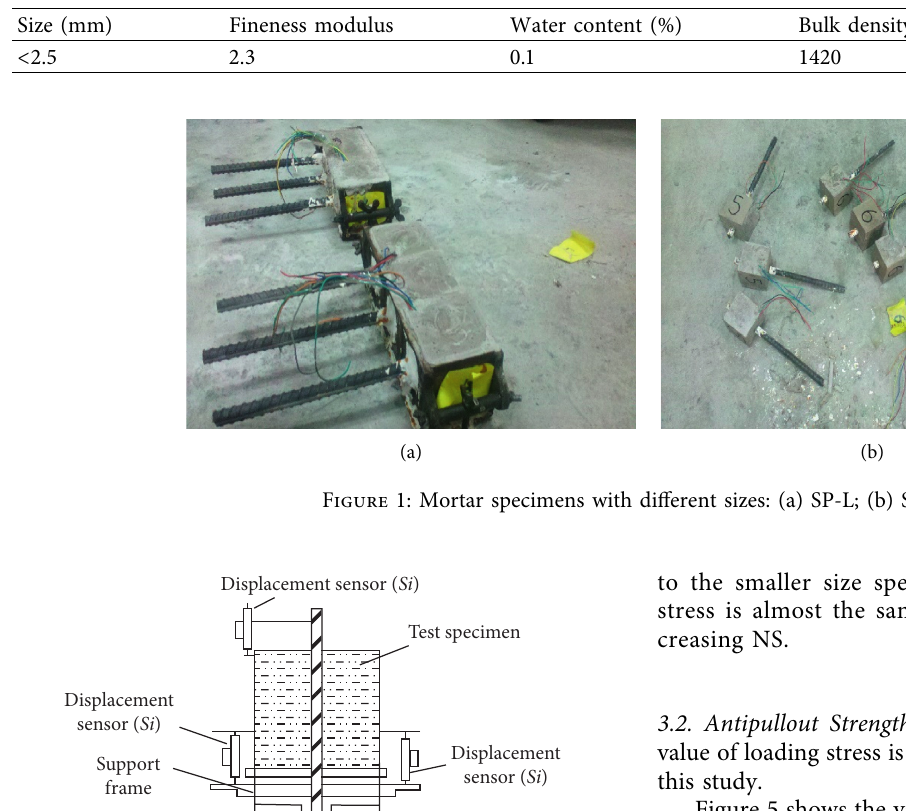
Table 3: Characteristics of the sand aggregates.